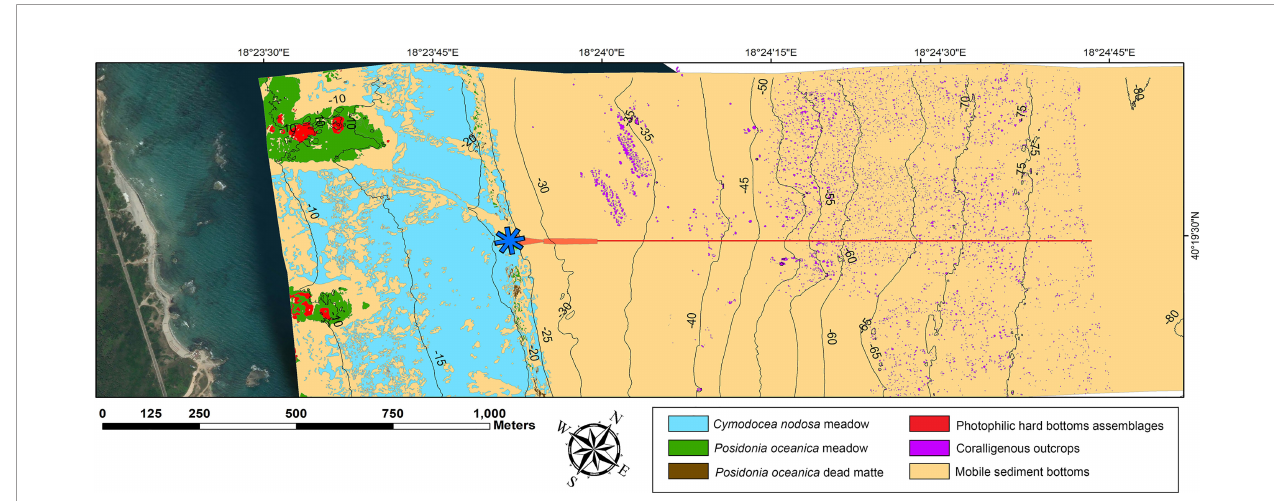
FIGURE 2 | Map of the benthic habitats identi fi ed along the TAP shallower section in front of the Italian coast, from 5 up to 80 m depth. The pipeline entry point in the microtunnel is indicated by a blue asterisk, the pipeline ’ s footprint is highlighted in